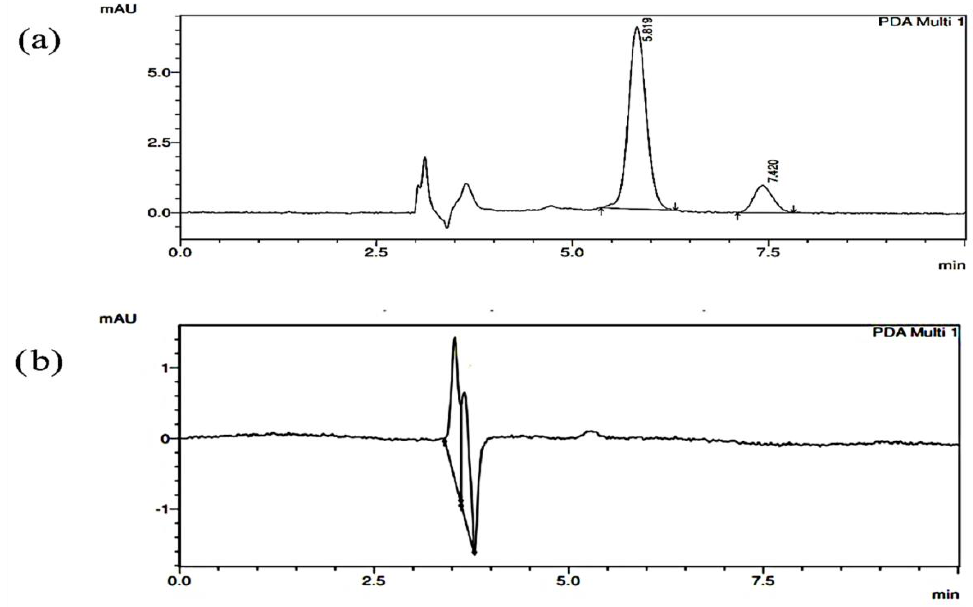
Figure 2. Representing chromatogram of ( a ) plasma spiked with IS and XH. ( b ) blank plasma.